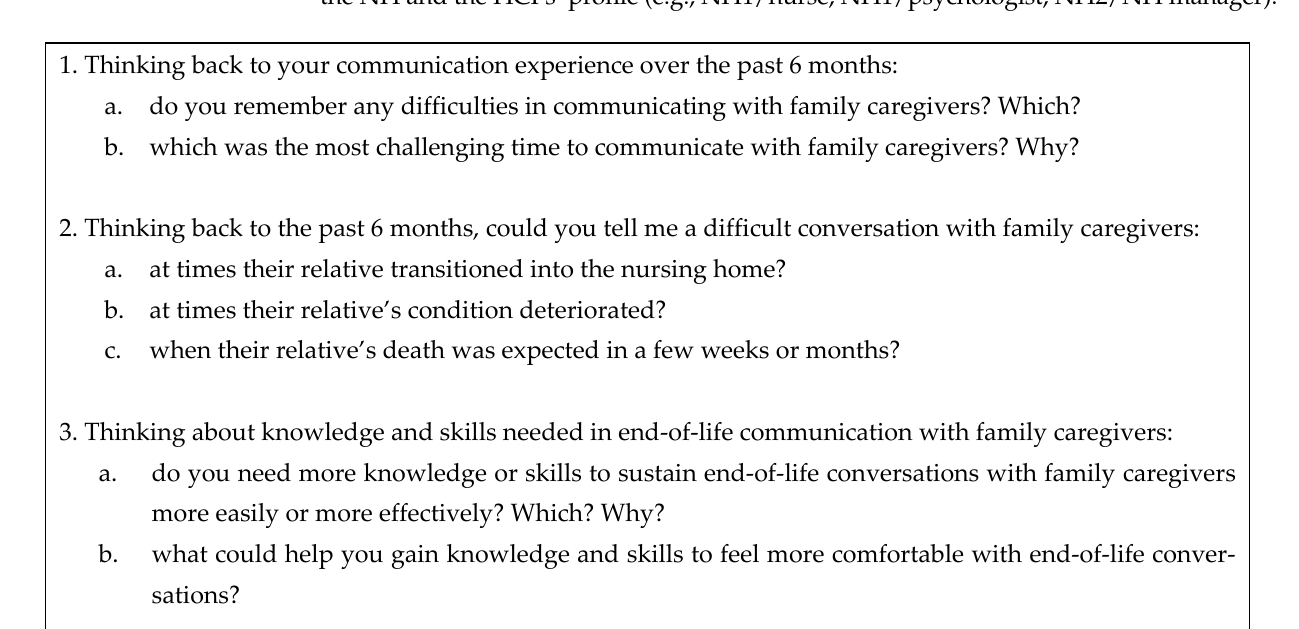
Figure 1. Interview